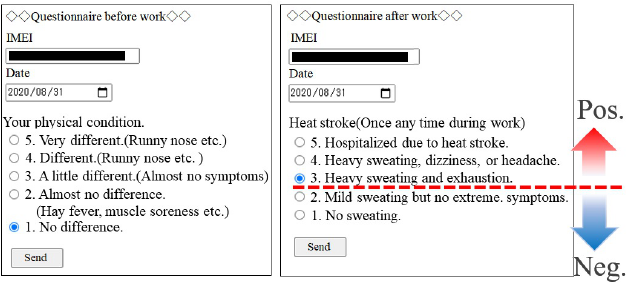
Figure 4. Survey form in before- and